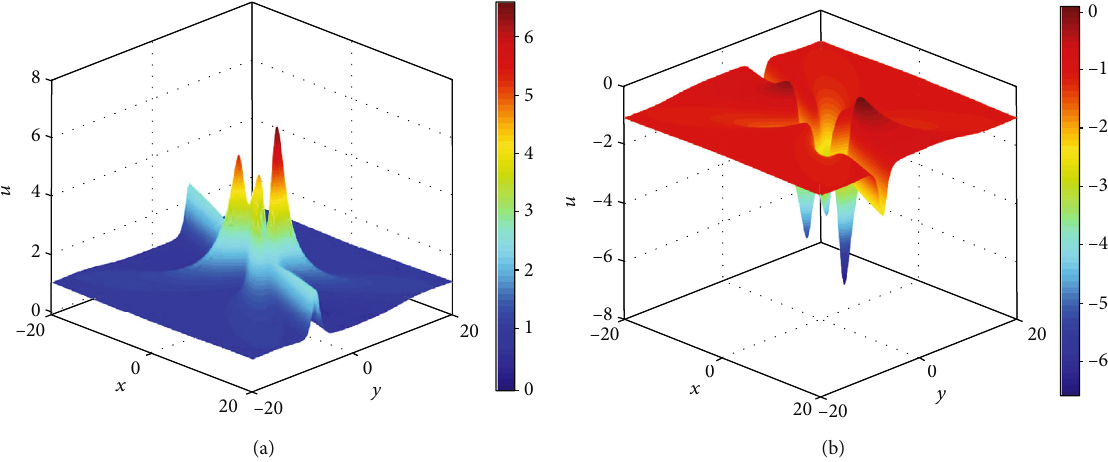
Figure 9: Two types of interactions between a lump and a stripe in Equation (1). (a) Bright-type interaction solutions with u (b) Dark-type interaction solutions with u 0 = − 1 and c = 1 .